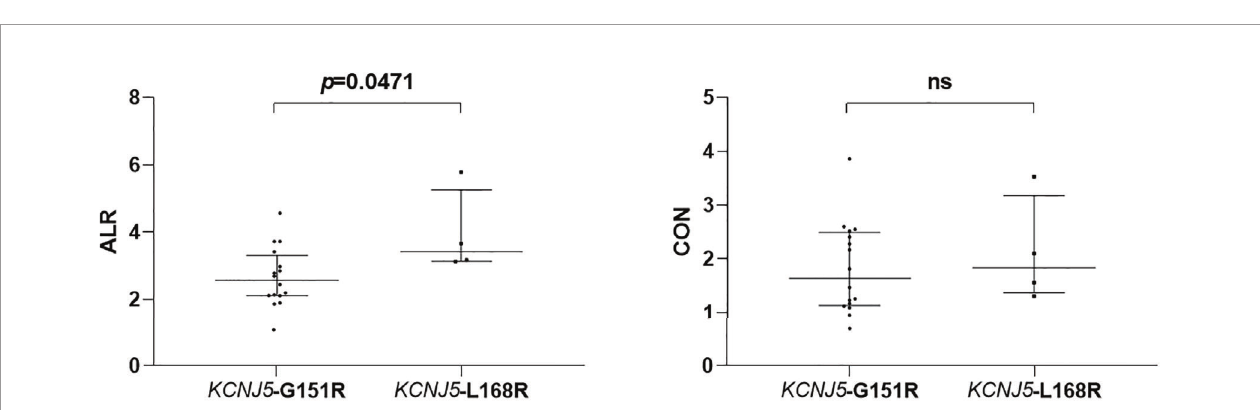
FIGURE 1 | Comparison of semiquantitative parameters of NP-59 adrenal scintigraphy according to KCNJ5 mutation status.